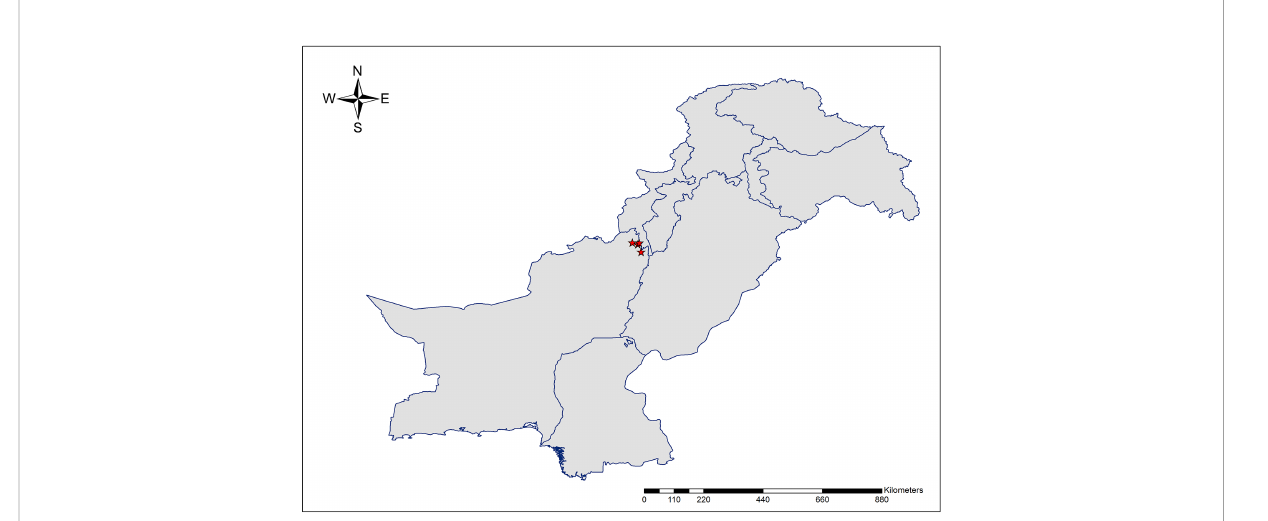
FIGURE 1 The geographic location of collected accessions of Allium sulaimanicum in Pakistan.